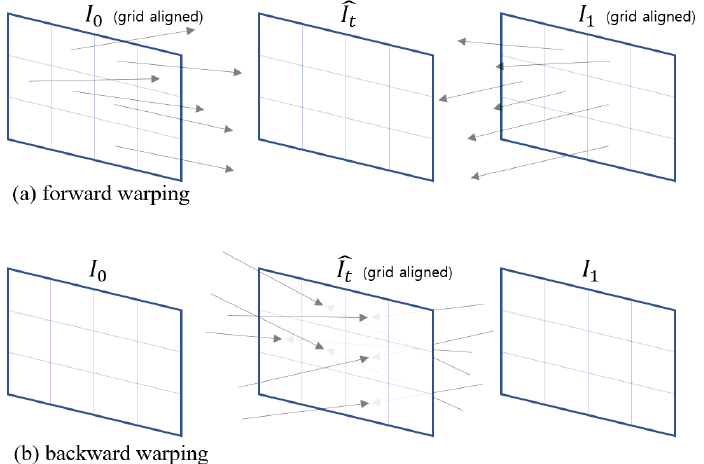
Figure 1. Differences in the alignment of interpolated images according to the warping